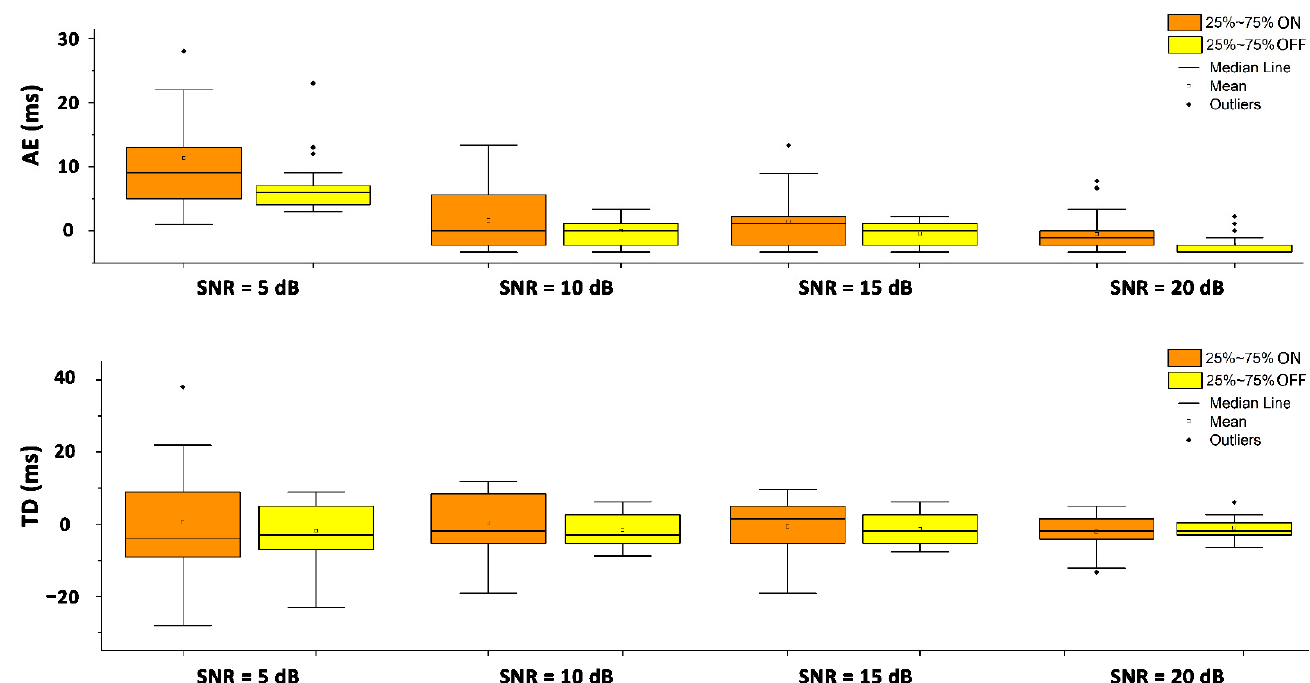
Figure 4. Whisker plots of absolute error (AE, upper panel) and time delay (TD, lower panel) com- puted over simulated sEMG co-contractions per SNR value expressed in dB. Orange bars represent the onset values. Yellow bars represent the offset values. The AE values computed for SNR = 5 dB were significantly higher ( p < 0.05) than all the AE values computed in the other three SNR conditions for onset and offset instants of the co-contraction. Table 1. Time delay (TD) ± SD computed over simulated sEMG co-contractions per SNR value, expressed in dB.